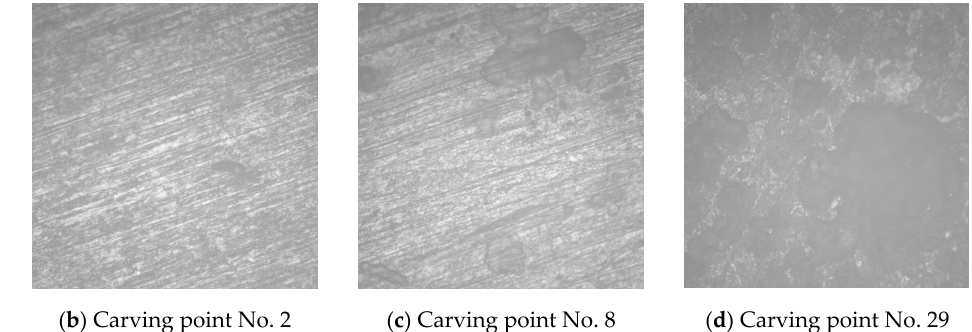
Figure 16. ( a – d ) Wear on the surface of guide vane ( P = 42.8 MW).